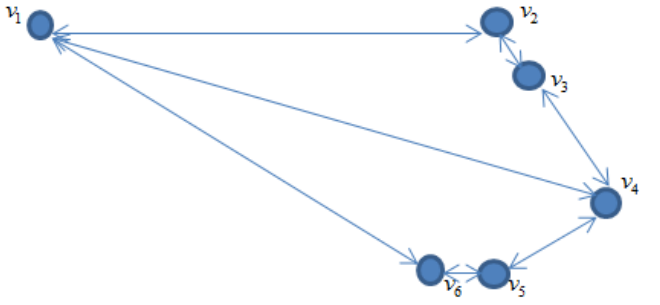
Figure 2. The graph tree for transport modes possible ways: v 1 —departure point; v 2, , v 3 , v 5 , v 6 —waypoints; v 4 —destination